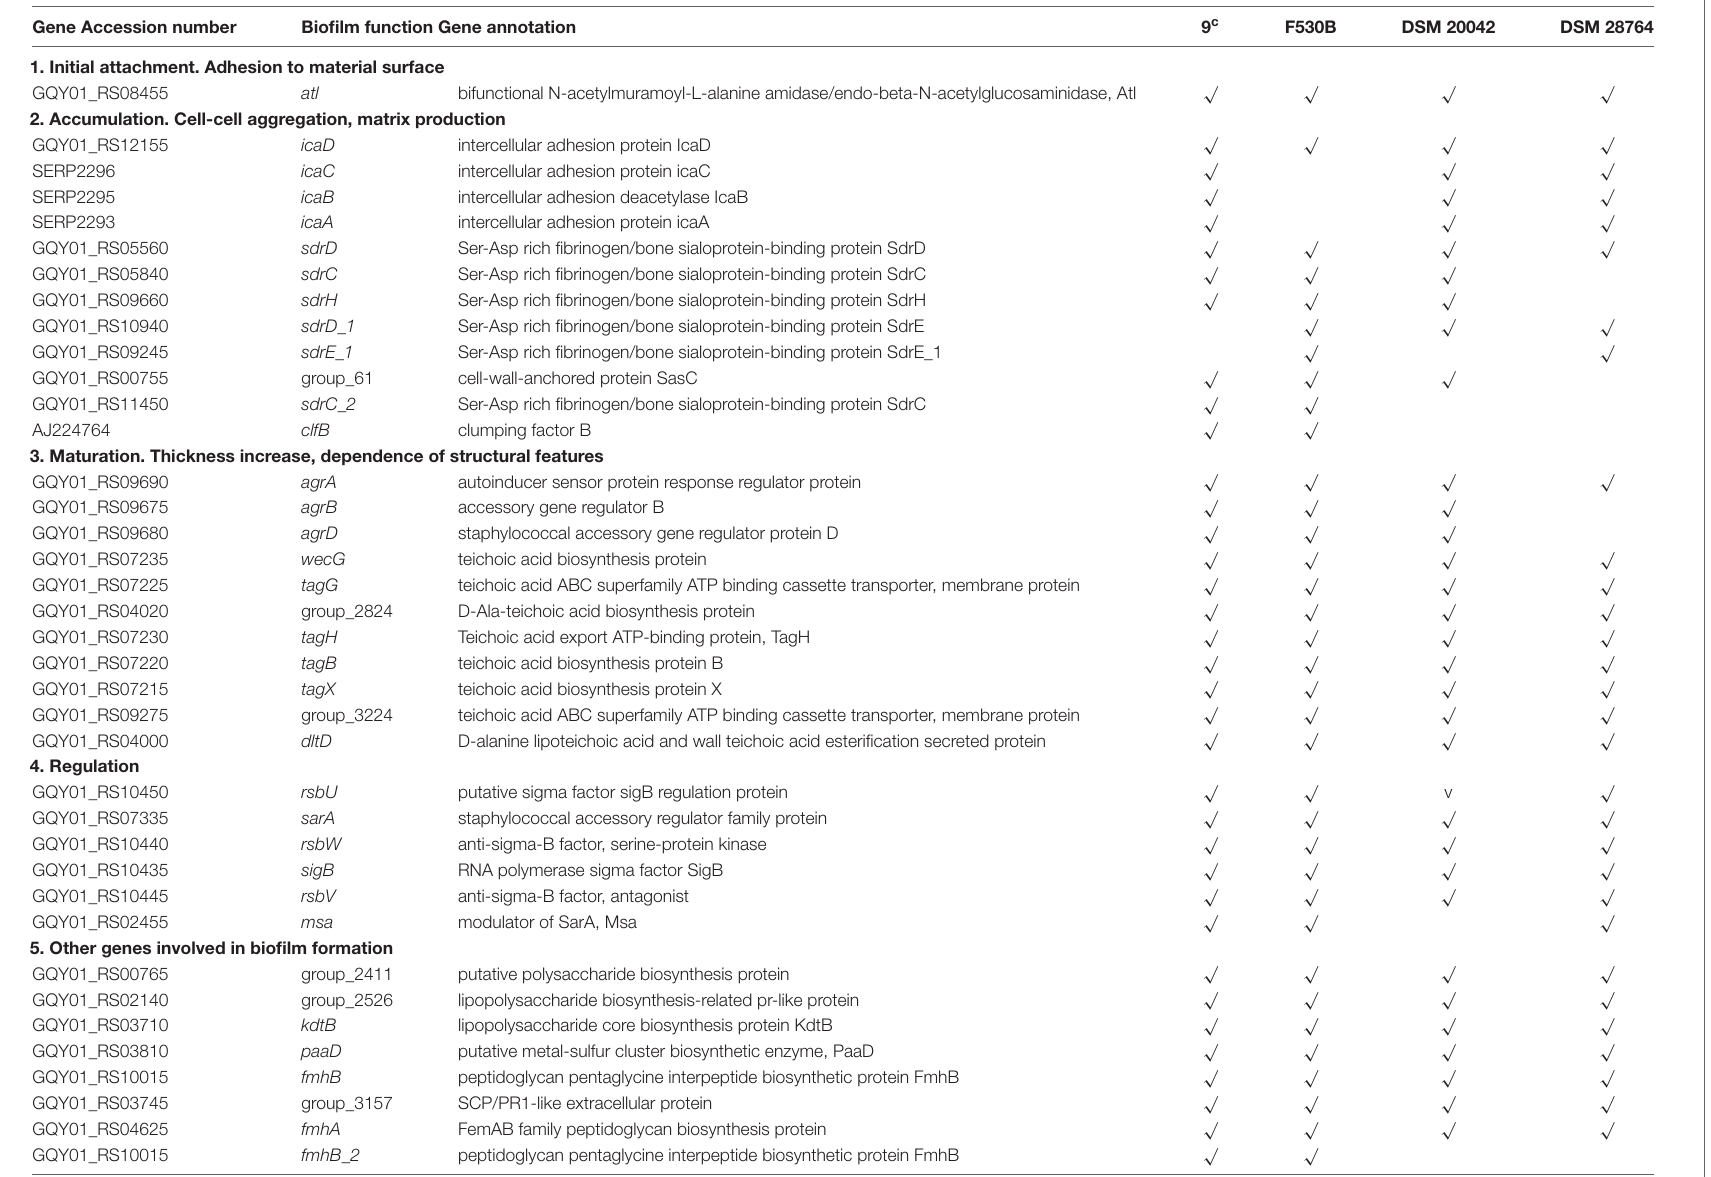
TABLE 2 | Comparison of presence of genes involved in biofilm formation in S. epidermidis stool isolates 9 c and F530B and skin strains DSM 20042 and DSM 28764. Gene Accession